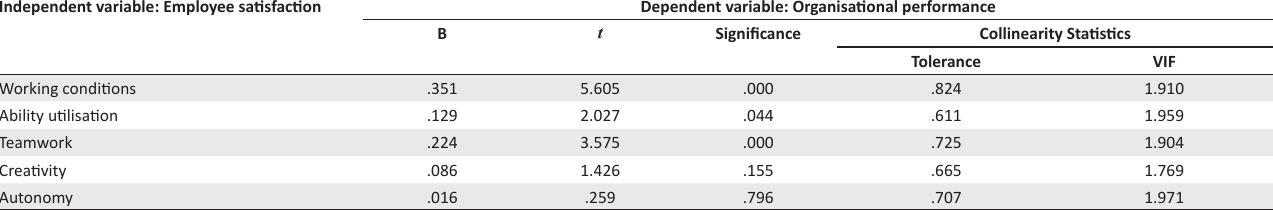
TABLE 4 : Regression analysis: Employee satisfaction and organisational performance. Independent variable: Employee satisfaction